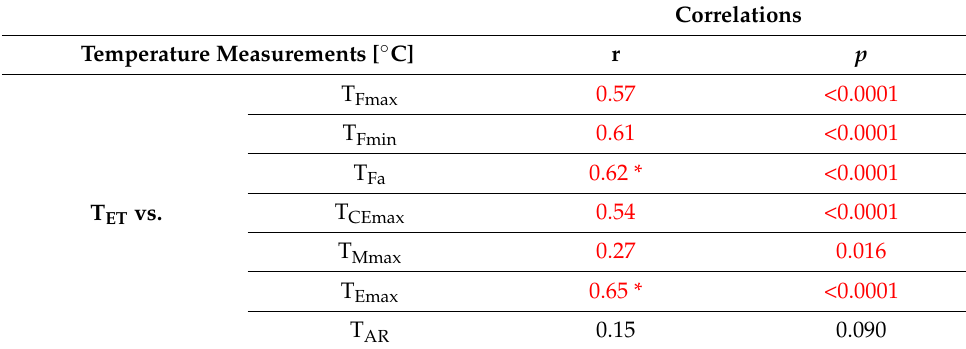
Table 3. Correlations between temperature values in the ear measured with the ear thermometer and temperature values of selected parts of the face measured with the thermal imaging camera. The statistically significant differences were marked with a red color. The highest Spearman correlation coefficient values are marked with